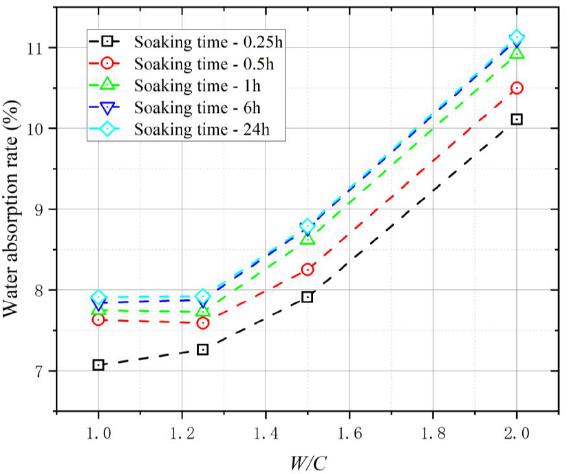
Figure 5. Effect of W/C of cement on water absorption of coral aggregates.